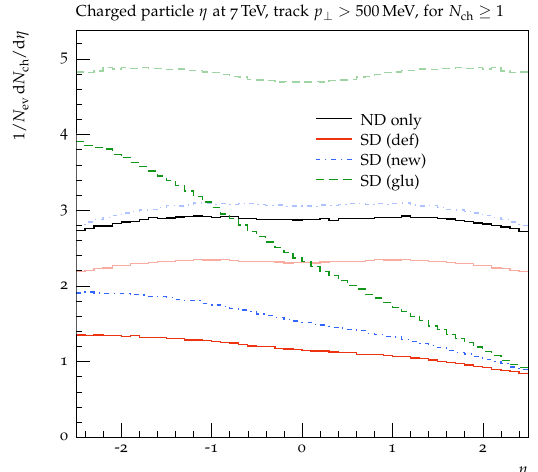
Figure 5 . Illustration of the shape of the multiplicity function in eq. (3.1) using the (cid:17) distribution as measured by ATLAS in [51]. The black and red lines are the shapes of standard non-di(cid:11)ractive and single di(cid:11)ractive events from P YTHIA 8 respectively. The green dashed and blue dash-dotted lines are single di(cid:11)ractive events generated by P YTHIA 8 using the modi(cid:12)cations presented in [9] and the modi(cid:12)cations presented in this article respectively. For each single di(cid:11)ractive line there is also a pale line corresponding to adding the mirror image to emulate a non-di(cid:11)ractive distribution (cid:18)a la